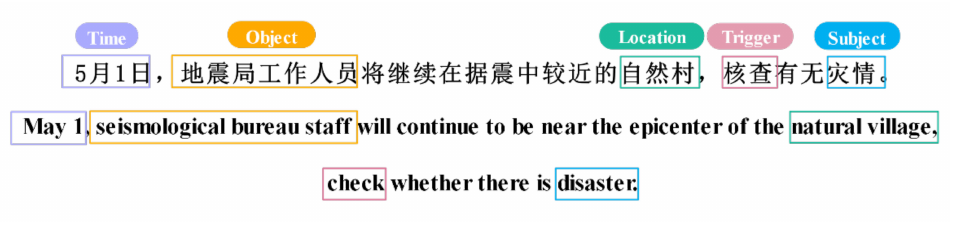
Figure 2. The five tuples of an emergency